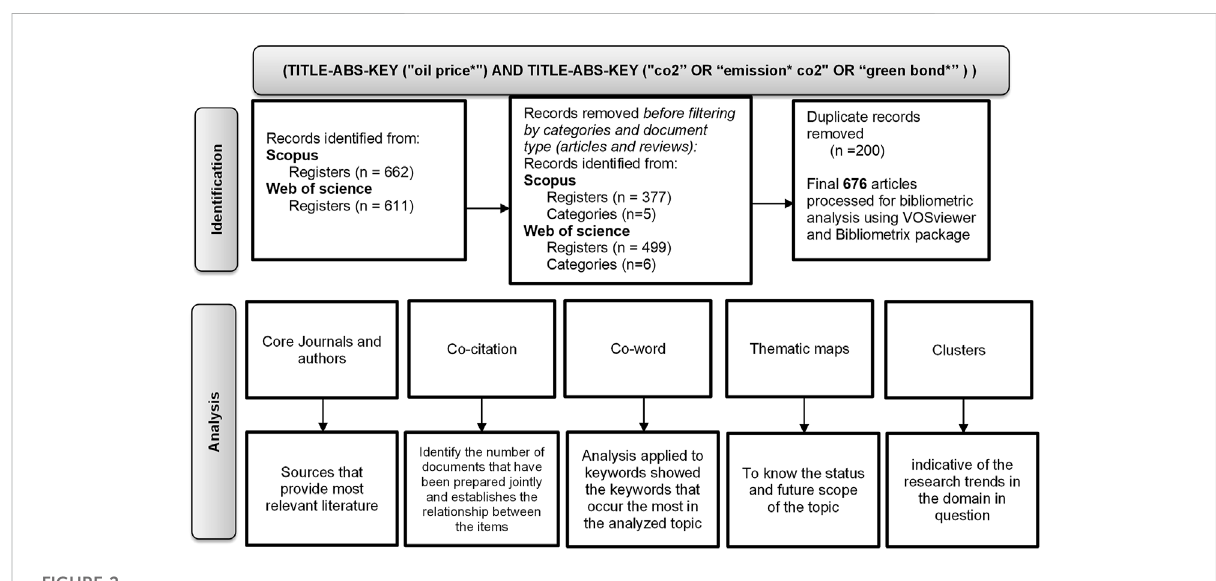
FIGURE 2 Literature search